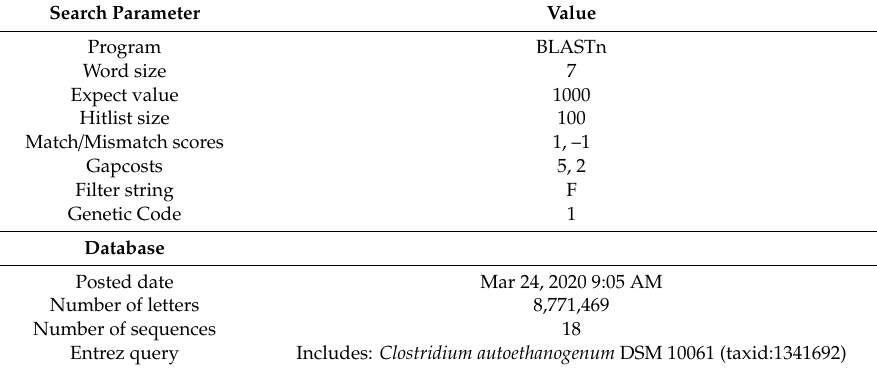
Table 1. Parameters of the basic local alignment search tool (BLAST) of all the bookmark protospacers and their associated protospacer adjacent motif (PAM) against Clostridium autoethanogenum